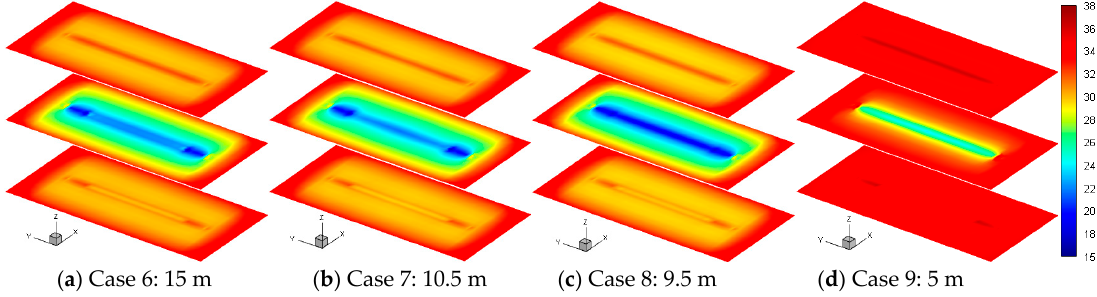
Figure 20. Comparison of σ xx distribution between different cases after 10 years, MPa. The profiles are shown in the top, middle and bottom layers, and the length in the z -direction is shown as 6.67 times the real size.